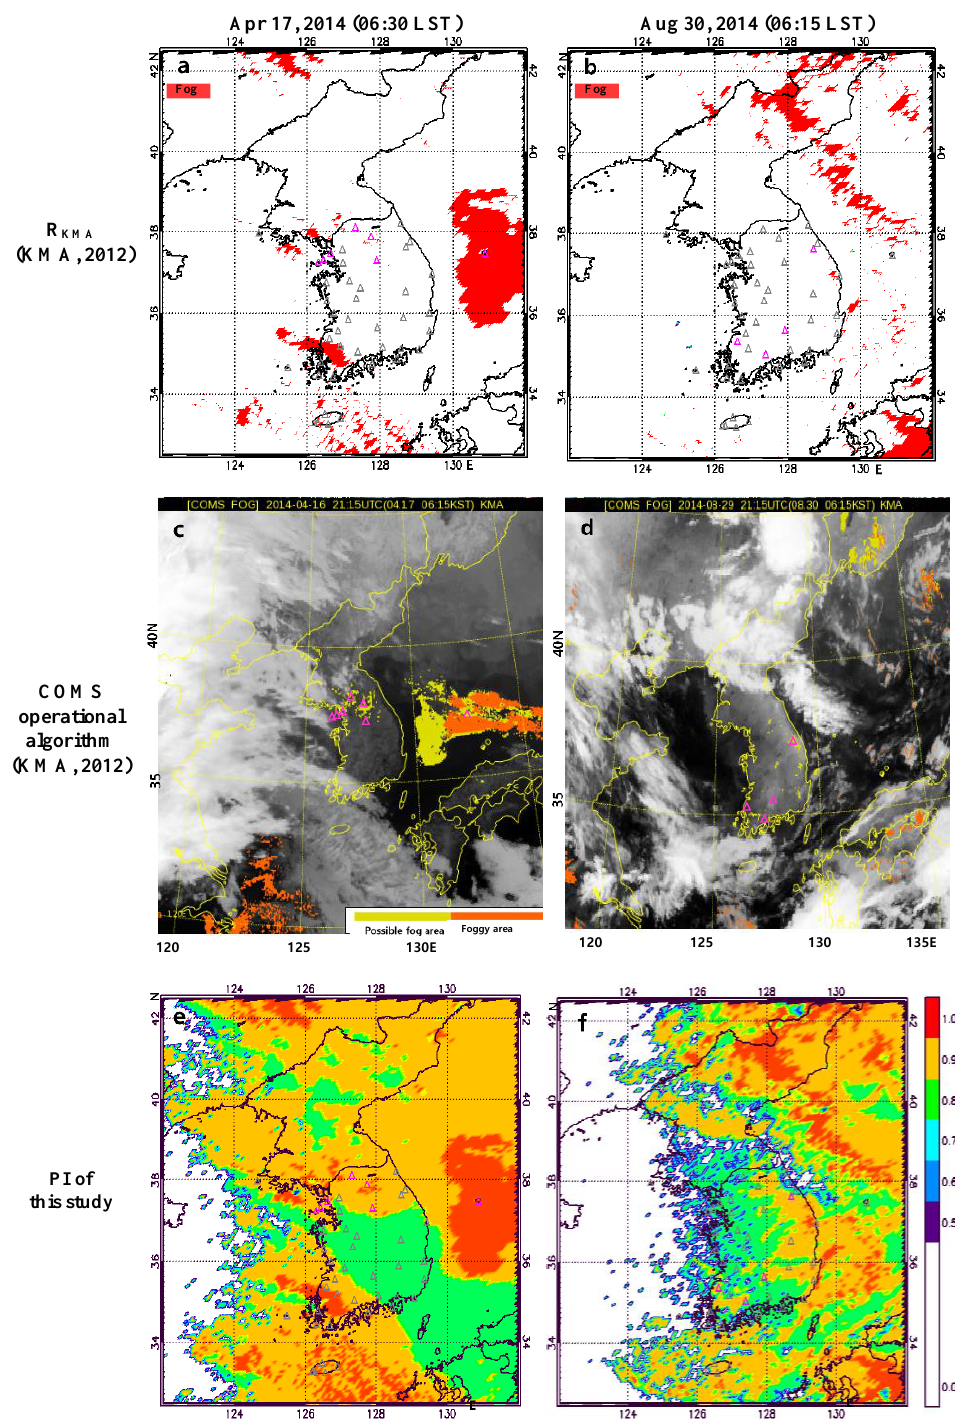
Figure 12. Spatial distributions of fog probabilities at dawn (06:30 LST) on 17 April 2014 near the Korean Peninsula from the three fog detection methods: ( a ) R KMA threshold [19], ( c ) the operational algorithm with a COMS image [19], and ( e ) the PI of this study. ( b ) As in Figure 12a, except for the date and time (06:15 LST on 30 August 2014). ( d ) Same as in Figure 12c, except for the date and time. ( f ) Same as in Figure 12e, except for the date and time. The white areas in Figure 12e,f mean ‘no fog’. The fog-detection case at summertime dawn is presented in the right-hand column of Figure 12, which also shows four fog occurrences at ground stations 10, 27, 38, and 45. While none of the